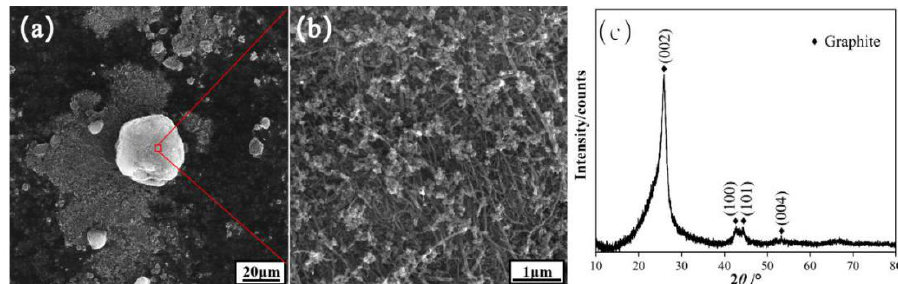
Figure 1. ( a – i ) Schematic diagram of preparation route for x % CNTs/Al-Cu-Mg-Si composites and semi-solid stir casting.